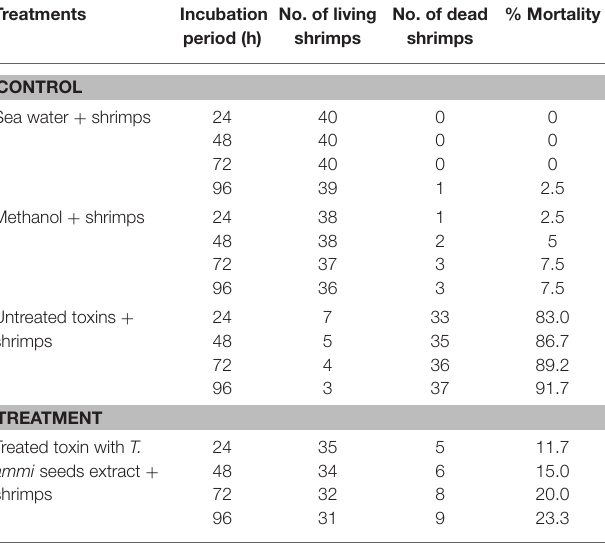
TABLE 3 | Percent mortality of brine shrimps ( Artemia salina ) larvae at 26 ◦ C after treatment with toxin (AFB1 and AFB2) detoxified with T. ammi seeds extract at various incubation